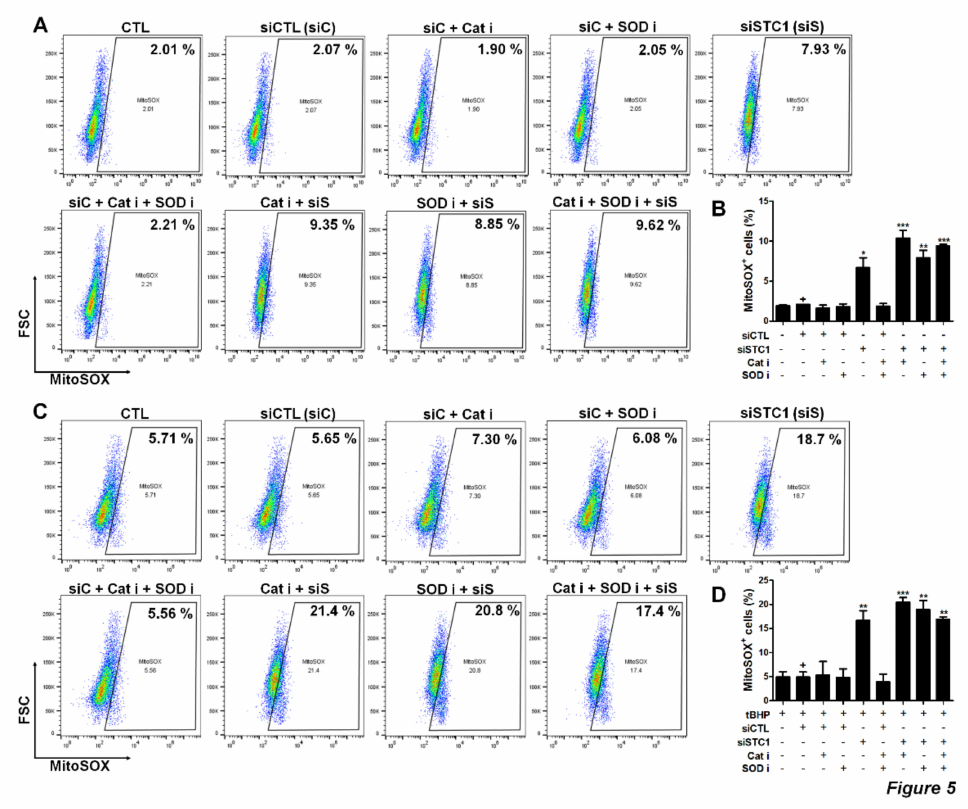
Figure 5. ROS regulation by STC1 in TMSCs. Mitochondrial ROS level in TMSCs after STC1, catalase or superoxide dismutase (SOD) inhibition was measured by staining with mitoSOX. mitoSOX + cells were determined by flow cytometry ( A ) and quantified ( B ). Tert-Butyl hydroperoxide (tBHP) was treated for the induction of ROS generation in TMSCs and mitoSOX + cells were determined by flow cytometry ( C ) and quantified ( D ). Dot plot data are representative results from two di ff erent TMSCs with similar tendency. Quantified data are integrated results of two technical replicates of TMSCs from two donors. * P < 0.05, ** P < 0.005, *** P < 0.001. Results are shown as mean ±